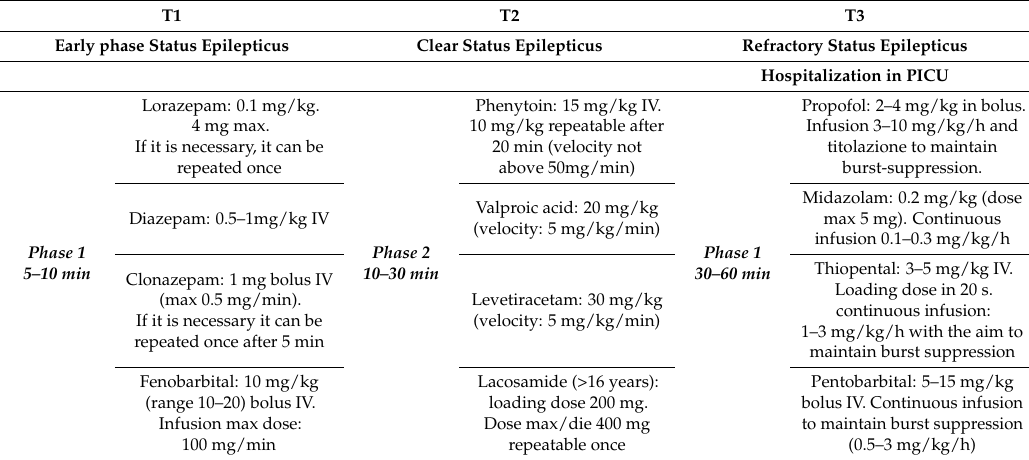
Table 7. Pharmacological